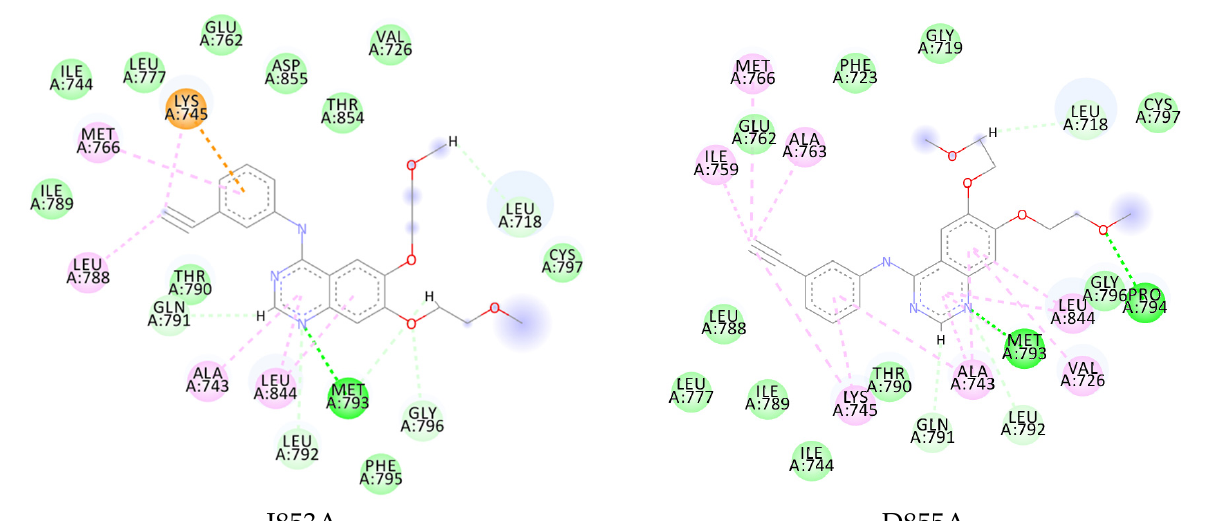
Figure 8. Two-dimensional interaction of erlotinib to G779A, Q791A, I853A, and D855A ( , hydro- gen bond; , van der Waals; , metal acceptor; , pi-sulfur; , pi-alkyl).